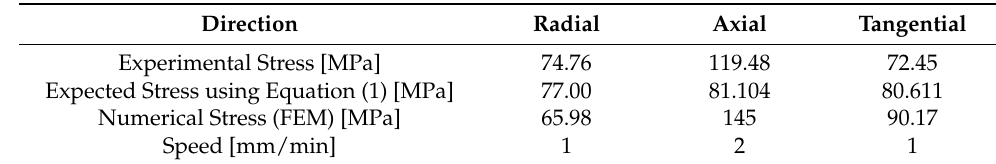
Table 4. Experimental, expected value using Equation (1) and numerical values of fracture stress at 3 g/cm 1.8ρ =